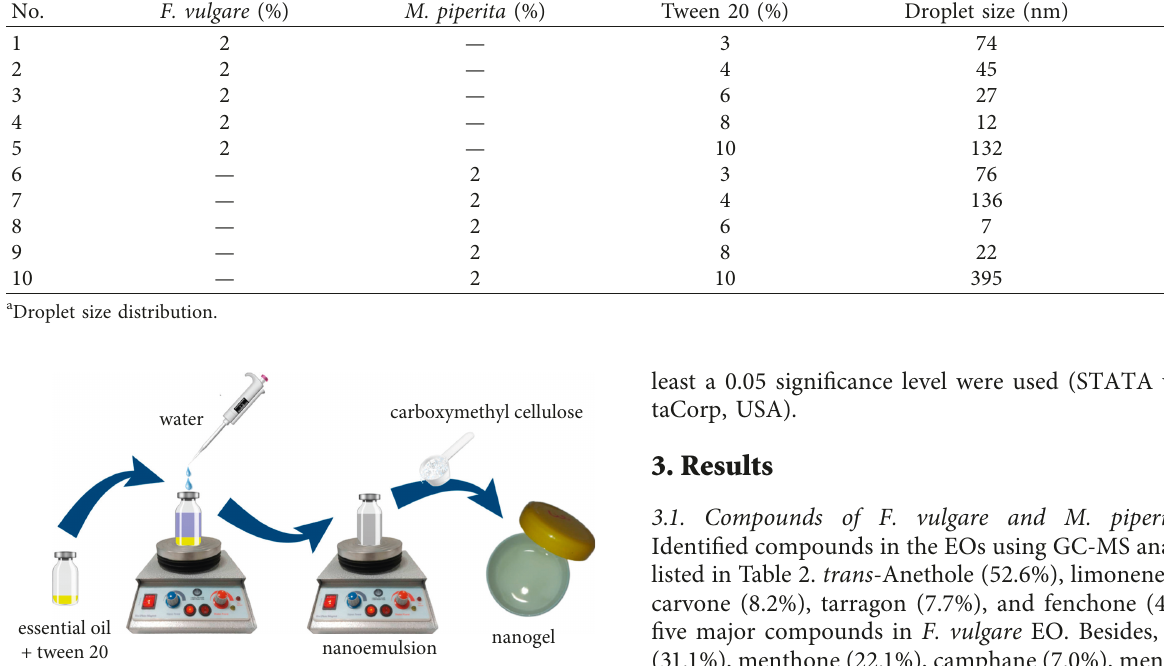
Figure 1: Preparation of nanoemulsion-based